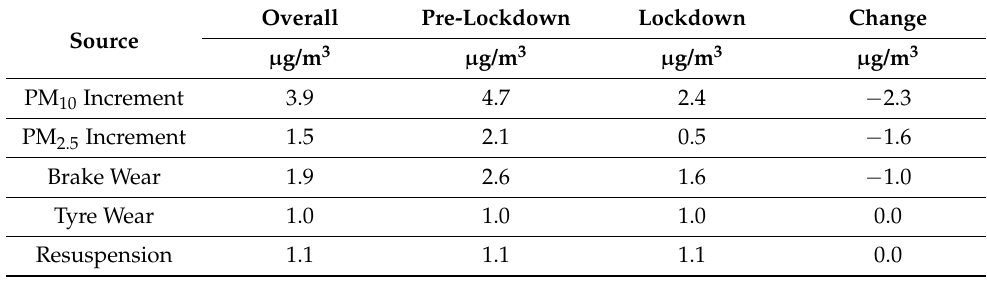
Table 3. Average PM 10 and PM 2.5 traffic increment and non-exhaust emission concentrations at Marylebone Road during the campaign ( µ g/m 3 ).